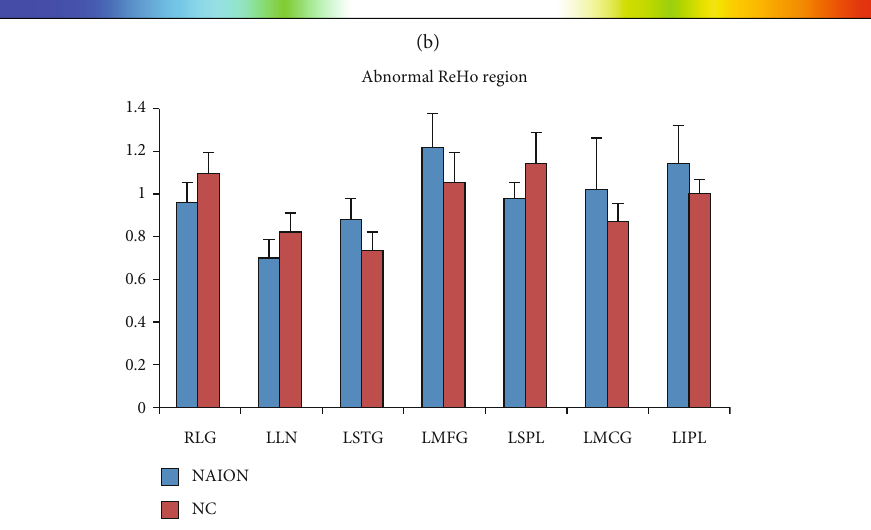
Figure 1: Spontaneous brain activity in patients with NAION and healthy participants Signi fi cant di ff erences in activity were observed in patients with NAION in the left middle frontal gyrus, left middle cingulate gyrus, left superior temporal gyrus, left inferior parietal lobule, right lingual gyrus, left putamen/lentiform nucleus, and left superior parietal lobule (false discovery rate corrected, clustersize > 23 voxels, P < 0 : 05 ) (a, b). The mean ReHo values for NAION and NC groups (c). Abbreviations: NAION: nonarteritic anterior ischemic optic neuropathy; NCs: normal controls; ReHo: regional homogeneity; L: left; R: